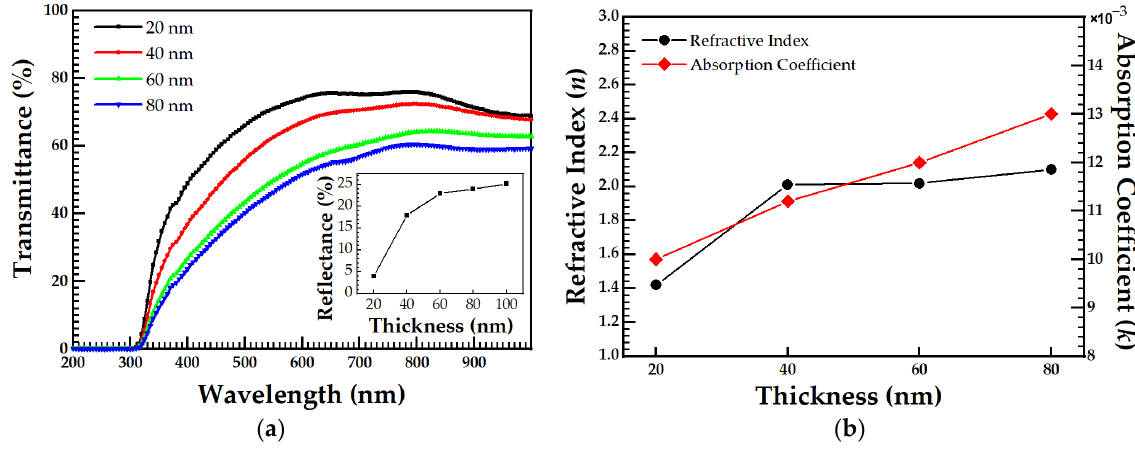
Figure 5. ( a ) Transmittance, ( b ) refractive index ( n ), and absorption coefficient ( k ) of the RF-PECVD DLC thin films with various film thicknesses: 20, 40, 60, and 80 nm. The inset of ( a ) shows reflectance of the RF-PECVD DLC thin films under the same film thicknesses.